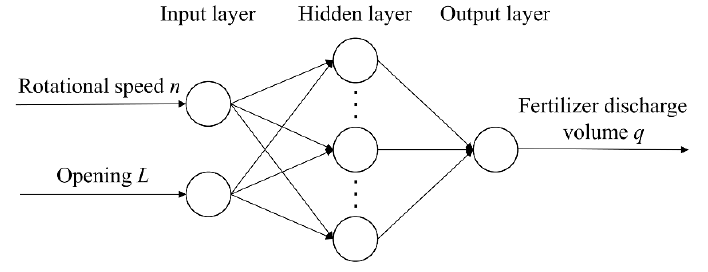
Figure 3. Structure of RBFNN-based fertilizer discharge prediction model.